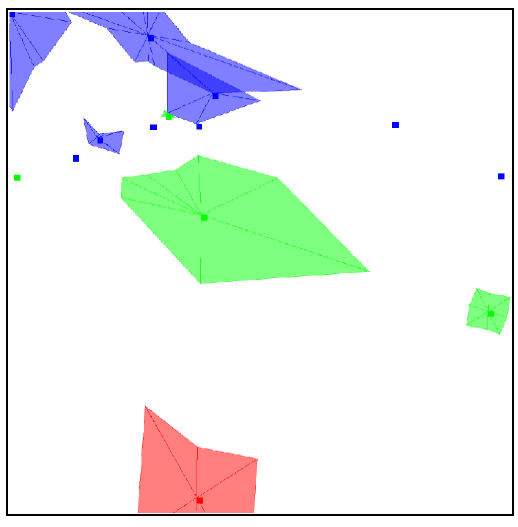
Fig. 13. A prototypical view on projected fuzzy points also displaying estimates for overlap/vicinity of neighbor- ing points.